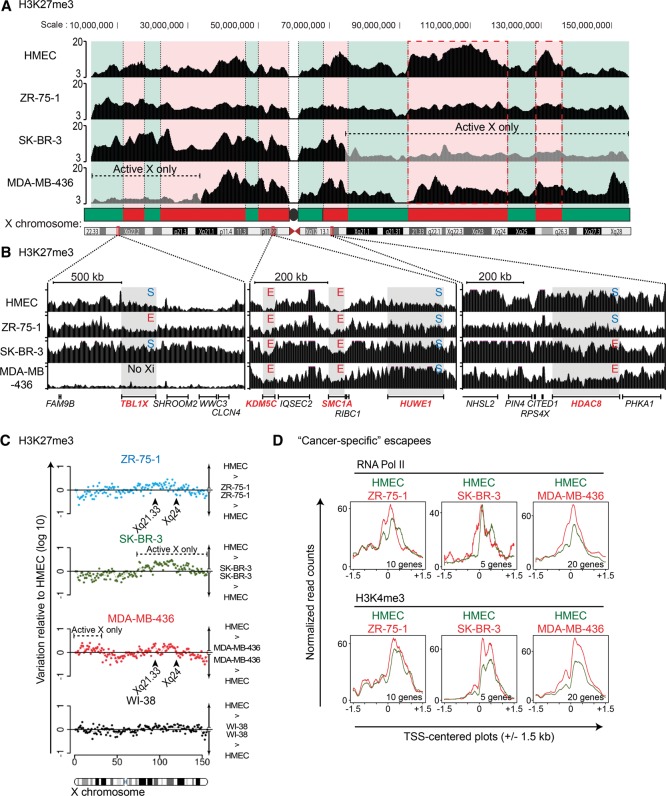
Chromatin landscape of the inactive X chromosome is disrupted in breast cancer cell lines. (A) Scheme of H3K27me3 enrichment (ChIP-seq) across the whole X chromosome. Red and green domains represent H3K27me3 and H3K9me3 enriched regions, respectively, as identified in normal human cells (Chadwick 2007). Regional loss of inactive X is indicated (and depicted by gray region). The two main enriched H3K27me3 domains’ loss in ZR-75-1 and MDA-MB-436 are depicted by the two red dotted rectangles. (B) H3K27me3 enrichment is detailed for three regions of the X chromosome carrying genes subjected (S) or escaping XCI (E). (C) Dot plots show variation of H3K27me3 enrichment along the X chromosome (1-Mb bins) of the three tumoral cell lines and WI-38 relative to HMEC. (D) TSS-centered plots (±1.5 kb) show RNA Pol II and H3K4me3 enrichment for the “cancer-specific” escapees (cf. Supplemental Table S1) of each tumoral cell line (red line) and HMEC (green line). The number of genes analyzed is indicated below each plot.